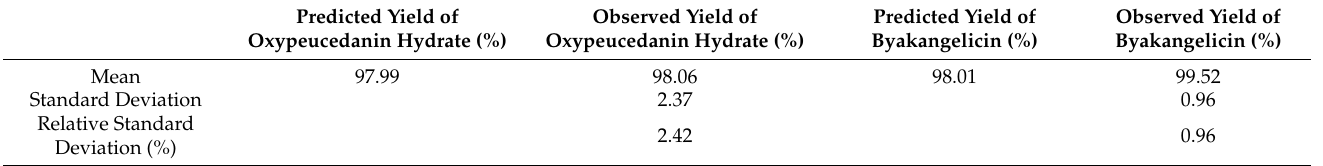
Table 4. Validation of the optimized extraction conditions.